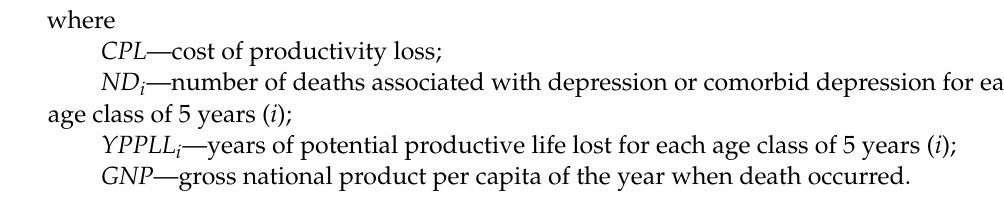
Table 1. Depression costs for patients in Romania between 2015 and 2021. Number of cases ≥18 ye ars